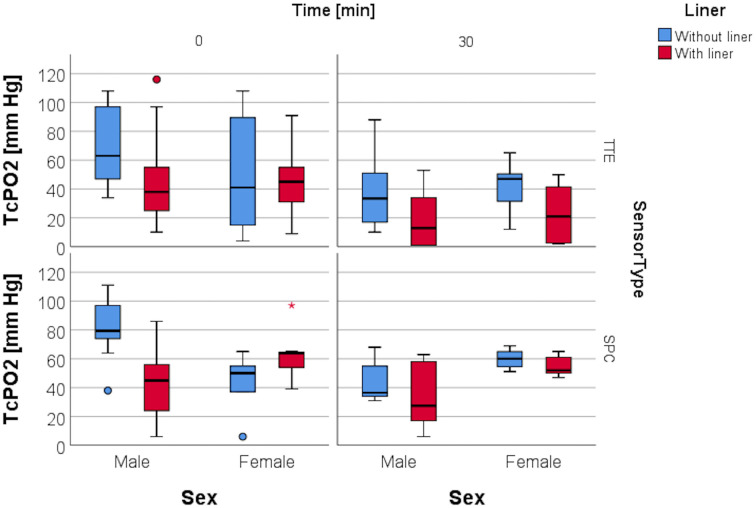
TcPO2 levels and sex.Boxplot depicting median TcPO2 levels of both sensors for T0 and T30 depending on sex with and without liner.